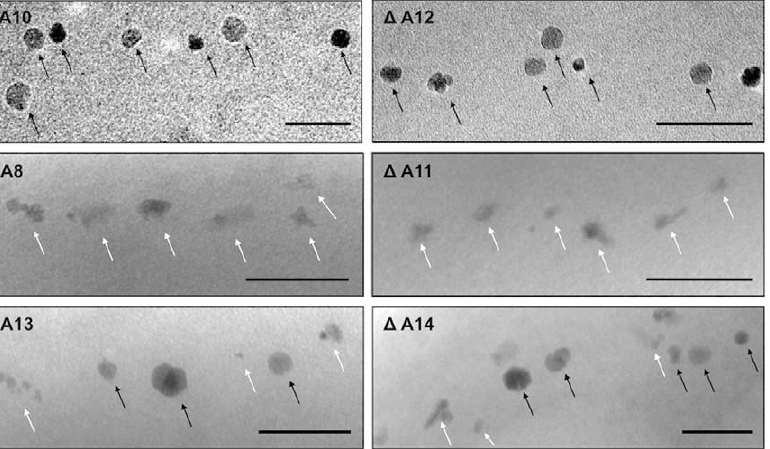
Figure 5. Comparison of magnetosome morphologies within several mutant strains of M.gryphiswaldense . Illustration of the combined effect on crystal morphology caused by stepwise excision of mms6 , mamGFDC and mamXY operons. Micrographs show various distinct crystal morphologies within strains D A10 and D A12 (cubicle-shaped, black arrows) and D A8 and D A11 (elongate shaped, white arrows) that are coexistent within the mutants D A13 and D A14. Scale bar: 100 nm.